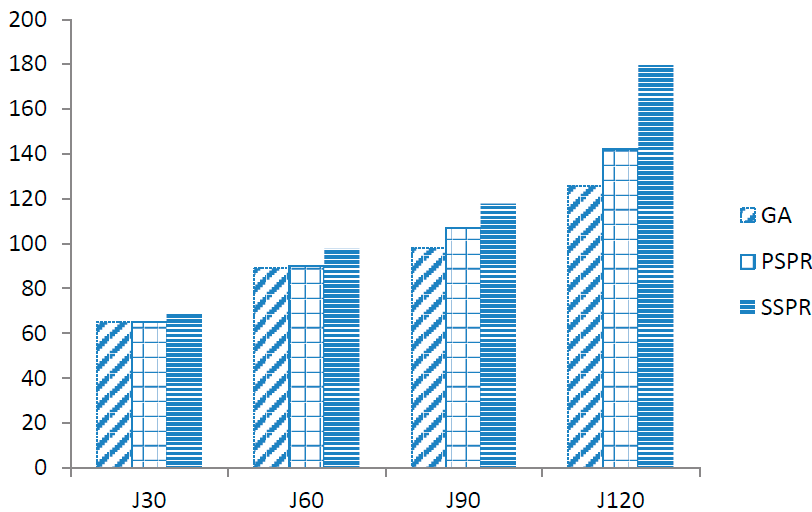
Figure 5. Comparison between the heuristics and the proposed hybrid genetic algorithm.